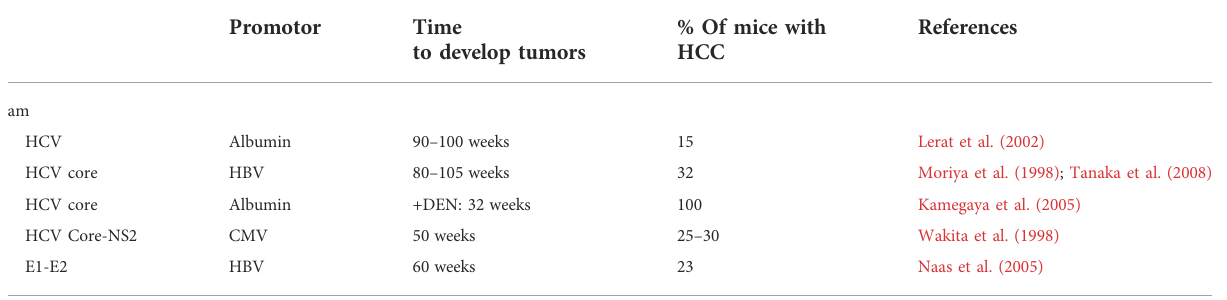
TABLE A1 Summary of transgenic